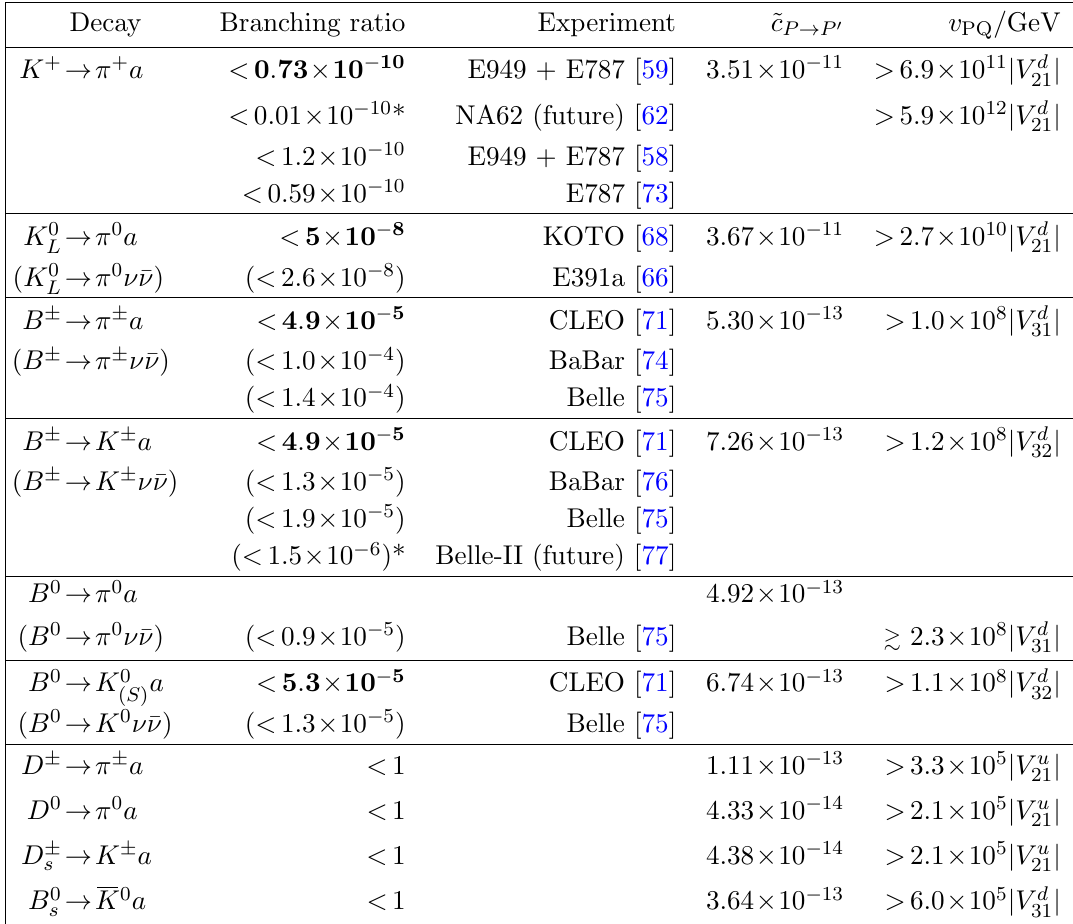
Table 2 . Branching ratios (upper limits) and corresponding bounds (lower limits) on the PQ- breaking scale v PQ from (cid:13)avour-violating meson decays. Bold font marks the current best limit from searches for P ! P 0 a , while parentheses mark the bound on the rare decay P ! P 0 (cid:23) (cid:22) (cid:23) , which should be comparable. Asterisks ( (cid:3) ) mark the expected reach of current or planned